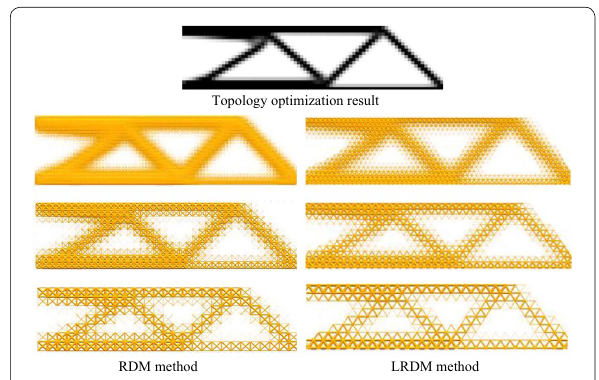
Figure 5 Lattice structures generated with various unit‑cell sizes using RDM and LRDM methods